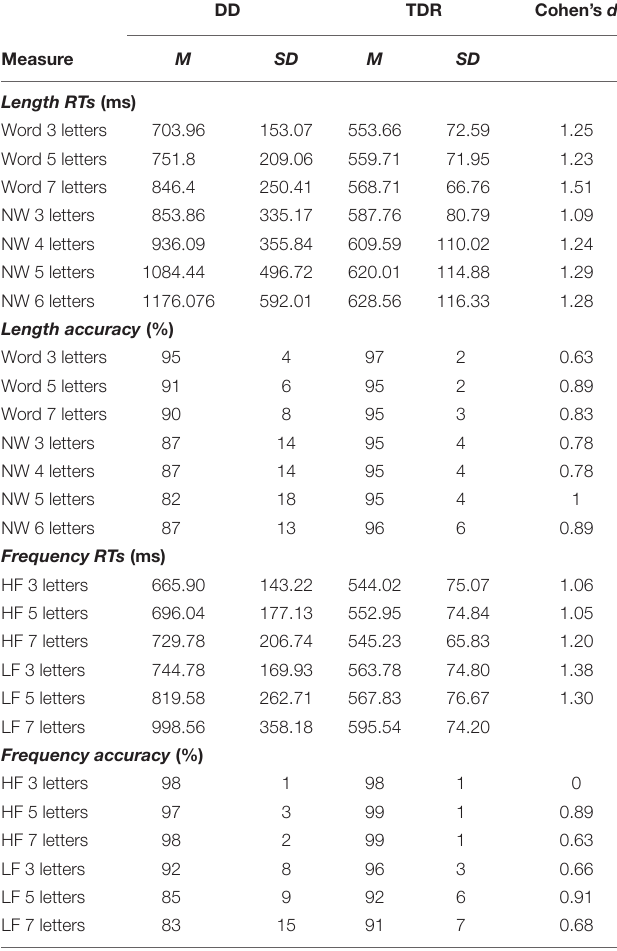
TABLE 1 | Descriptive statistics for reading speed and accuracy as a function of group.